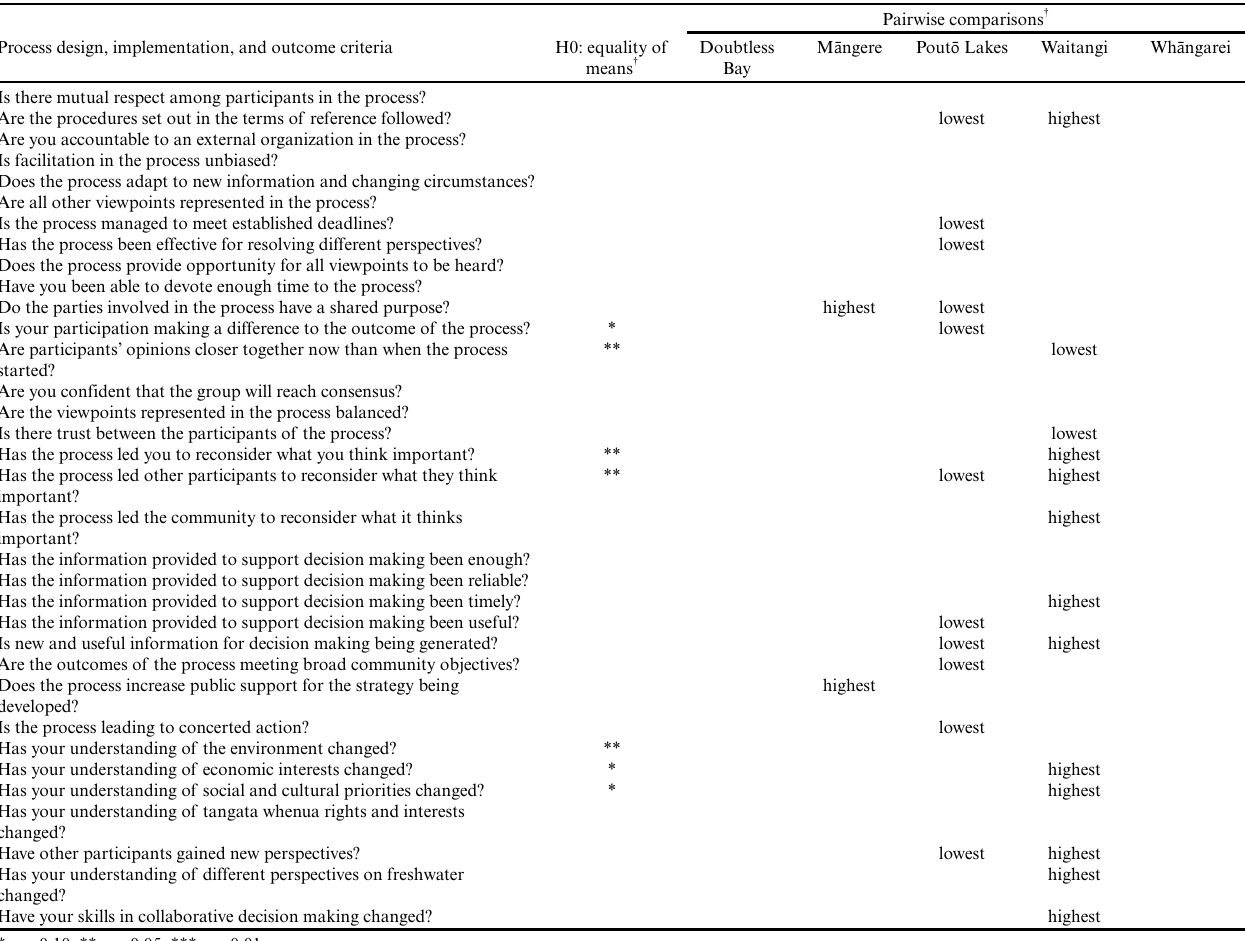
Table 8 . Northland equality of means for a single point in